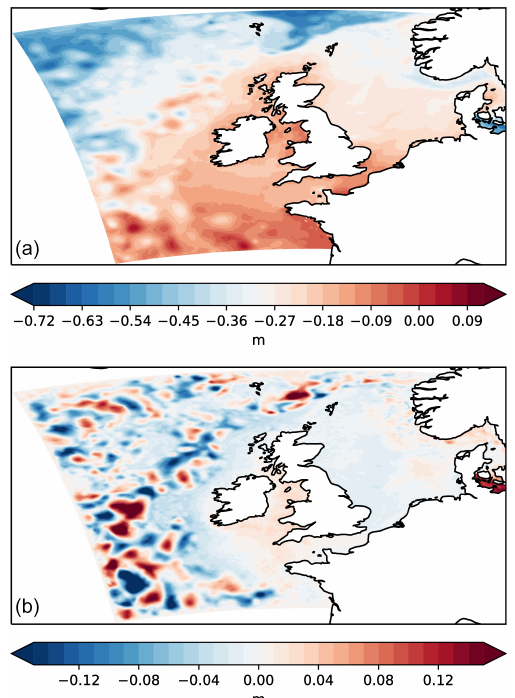
Figure 2. Nature run 25h mean SSH for an example day (30 June 2018, a ) and the difference (free – nature bias, b ) in the same field from the free